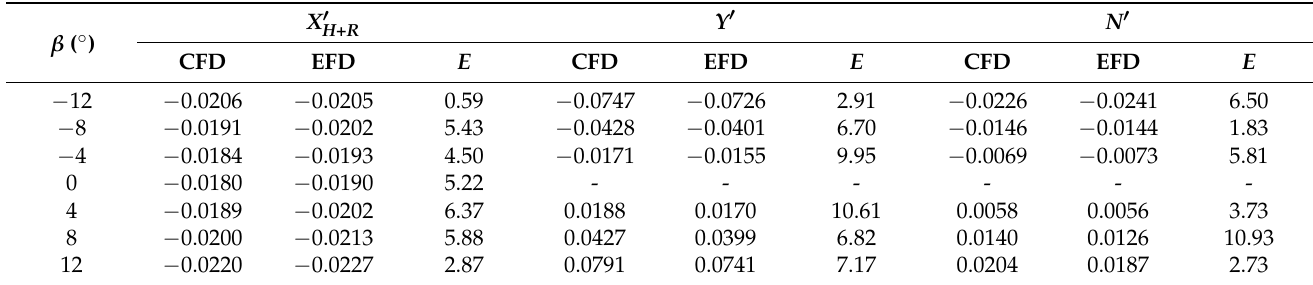
Table 13. The error between the CFD computed results and EFD data for water–air flow simulation, Fr = 0.201.